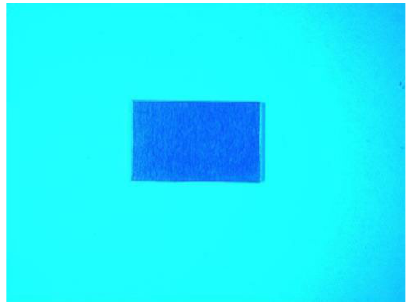
Figure 1. Image acquisition (blue light source).